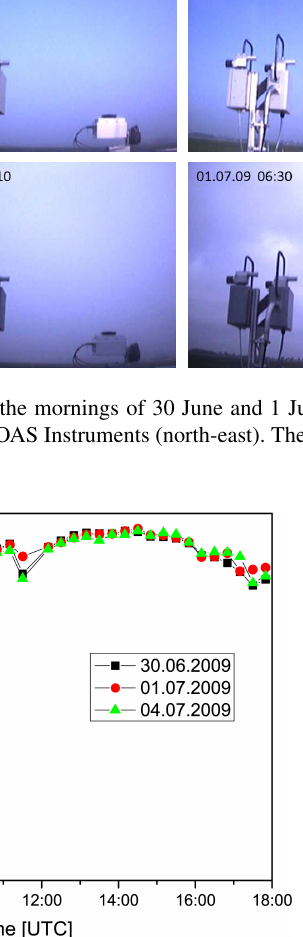
Figure 9. Diurnal variation of the degrees of freedom for signal from the Heidelberg retrieval for 30 June as well as 1 and 4 July